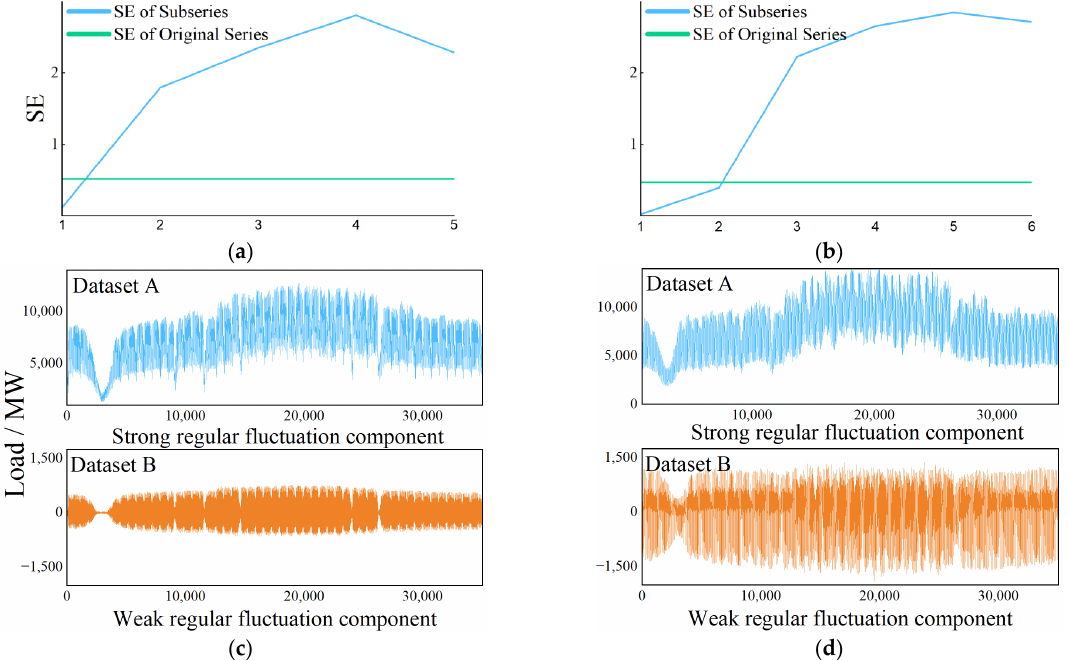
Figure 5. Subseries sample entropy and reconstruction: ( a ) subseries sample entropy of dataset A; ( b ) subseries sample entropy of dataset B; ( c ) reconstructed components of dataset A; ( d ) reconstructed components of dataset